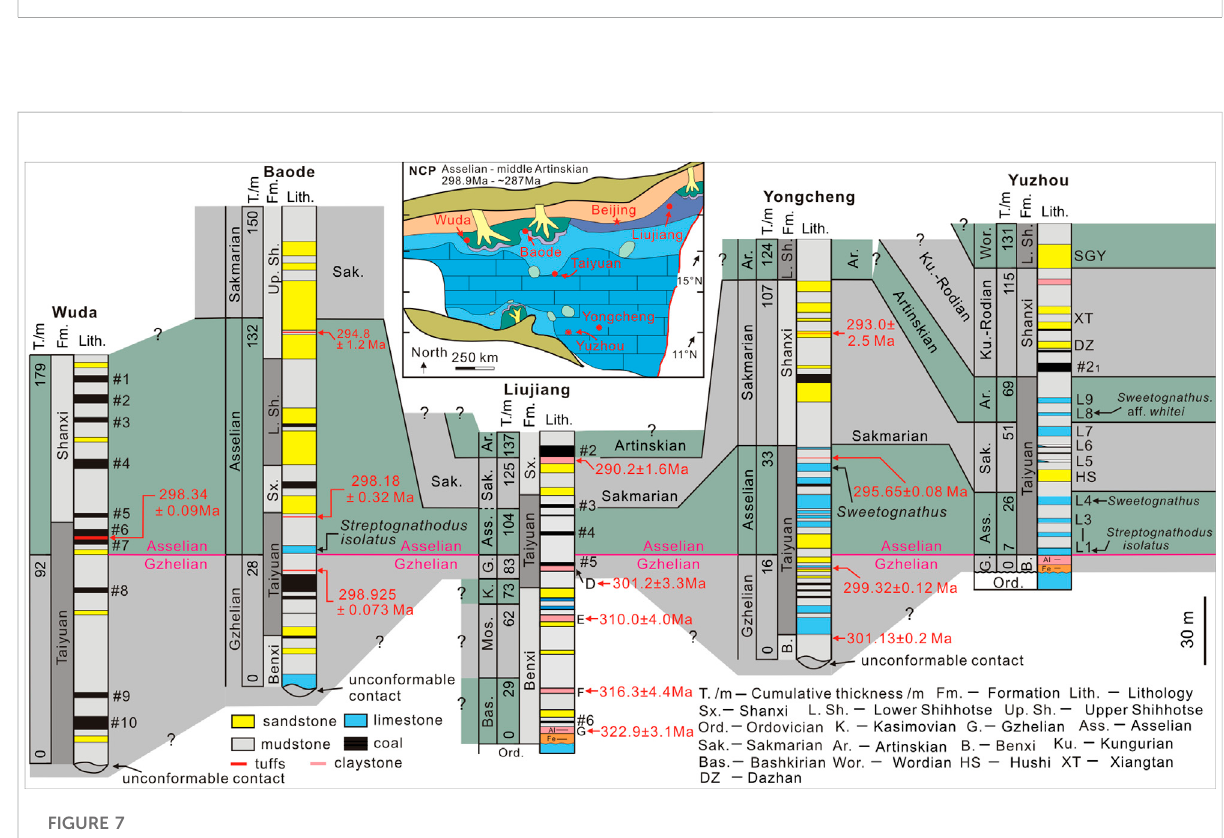
FIGURE 7 Chronostratigraphic and lithostratigraphic correlation of Carboniferous and Permian in the North China Plate (NCP). Lithology and age data of thesectionsatWuda(Schmitzetal.,2020),Baode(Wuetal.,2021),andLiujiang(Luetal.,2021a)andunpublisheddata,Yongcheng(Yangetal.,2020) and Yuzhou (this study) organized from north to south on the NCP during the Late Pennsylvanian to the earliest Guadalupian. Lithofacies paleogeographic map of the NCP modi fi ed from (Shao et al., 2014).